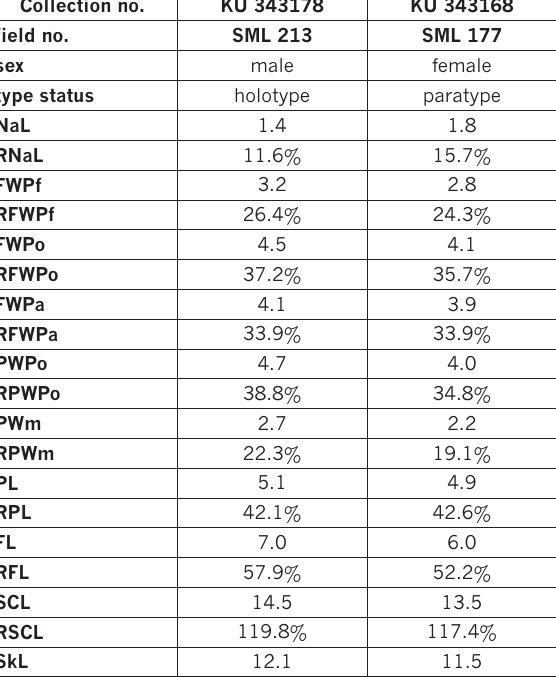
Table 2. Osteological measurements based on micro–CT scans of the skulls of the male holotype and an adult female of Calum- ma roaloko sp. n. All measurements in mm. For abbreviations, see Materials and